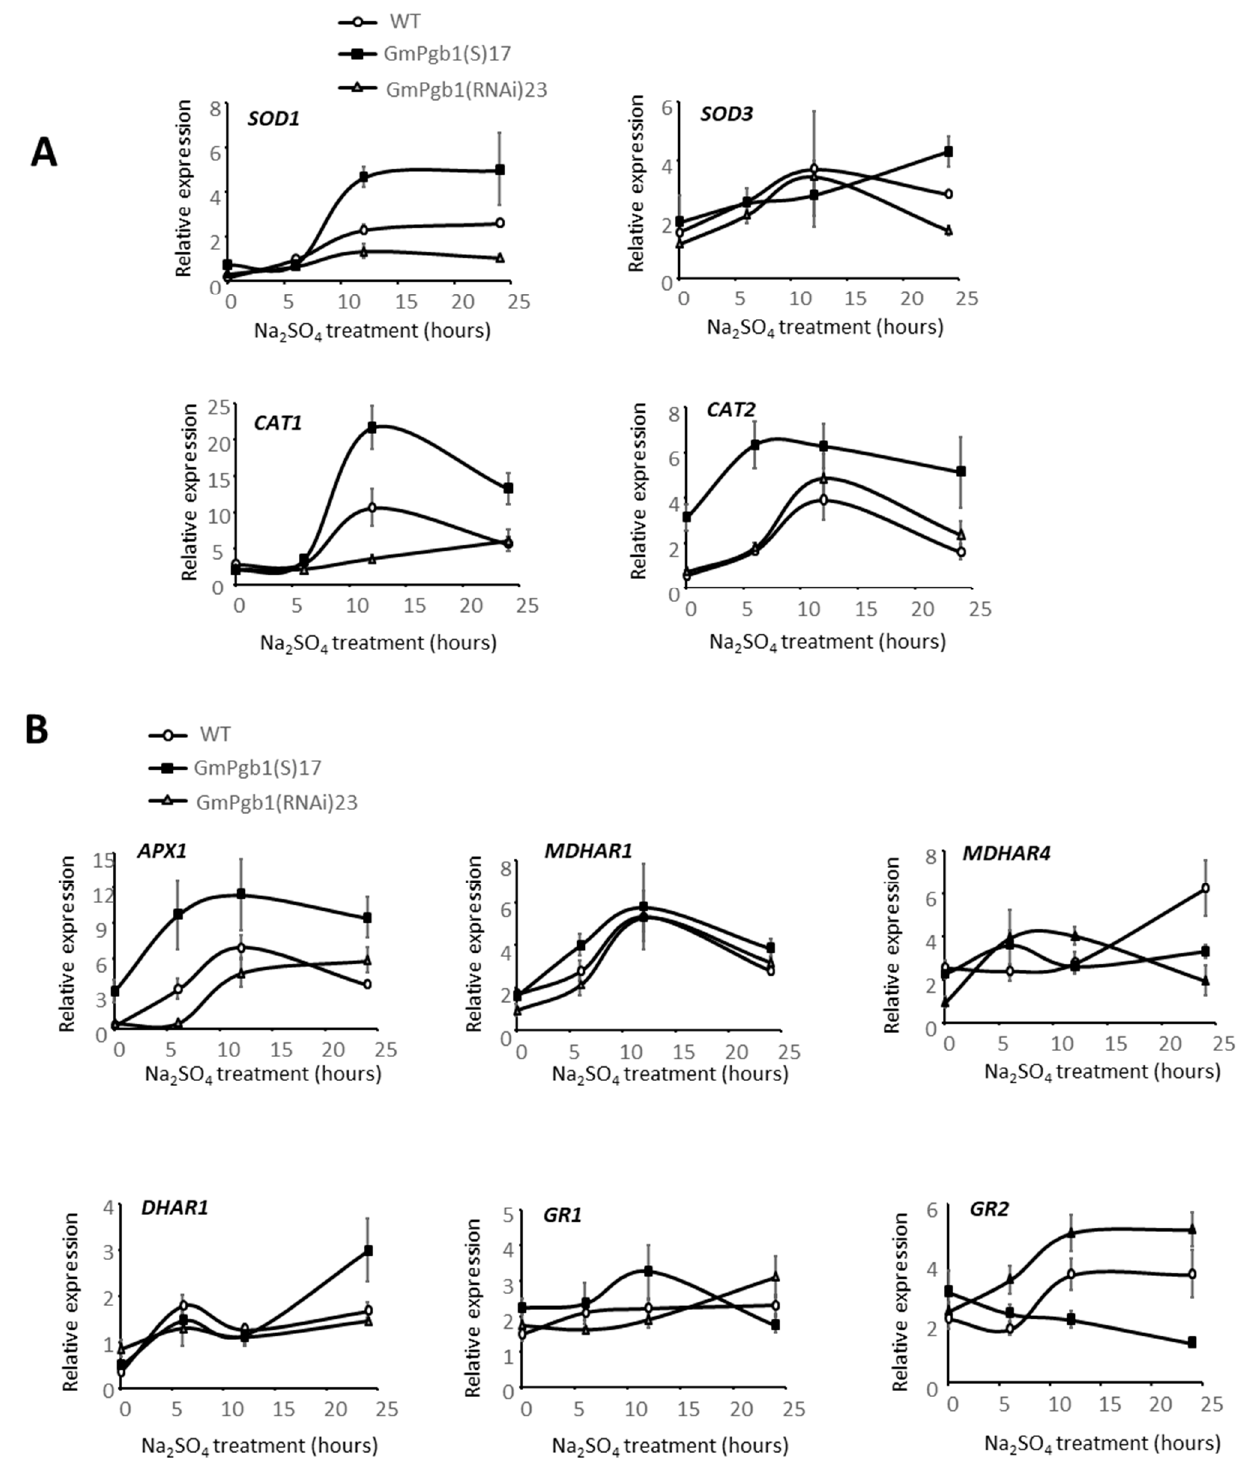
Figure 6. Relative transcript levels of antioxidant enzymes in leaves of soybean plants exposed to Na 2 SO 4 . Measurements were taken in the WT line and the lines overexpressing (GmPgb1(S)17) or downregulating (GmPgb1(RNAi)23) GmPgb1 . Values are the means ± SE of three biological replicates, each consisting of at least three plants. ( A ) Superoxide dismutase (SOD1, 3) and catalase (CAT 1, 2). ( B ) Ascorbate peroxidase 1 ( APX1 ), monodehydroascorbate reductase (MDHAR1, 4), dehydroascorbate reductase (DHAR1), and glutathione reductase (GR1, 2).